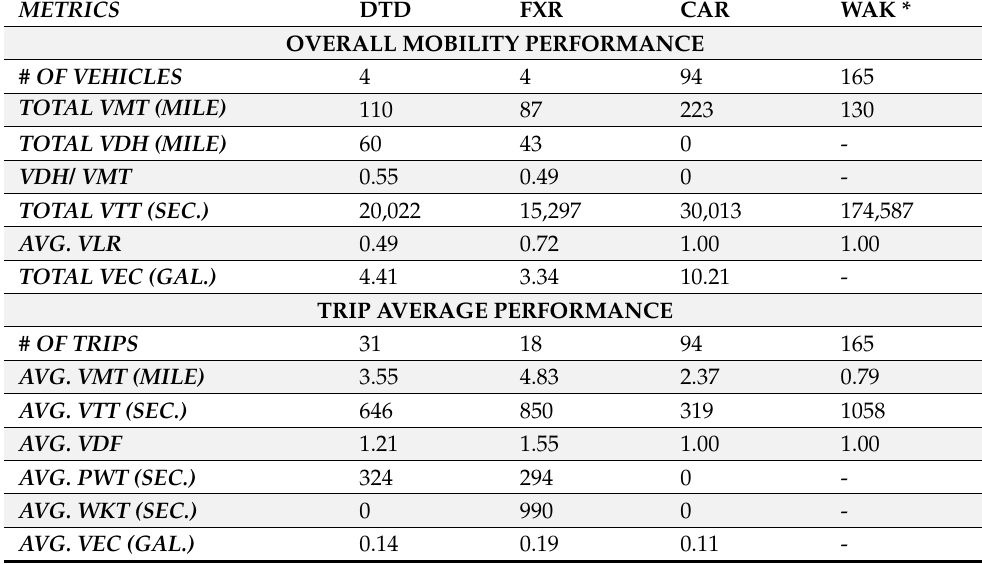
Table 1. Performance Metrics of Mode Choice